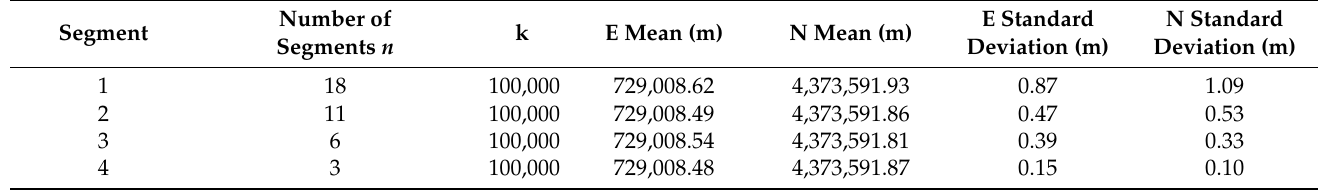
Table 3. Segment type, number of segments k, East and North means, and the bootstrapping standard deviations associated.